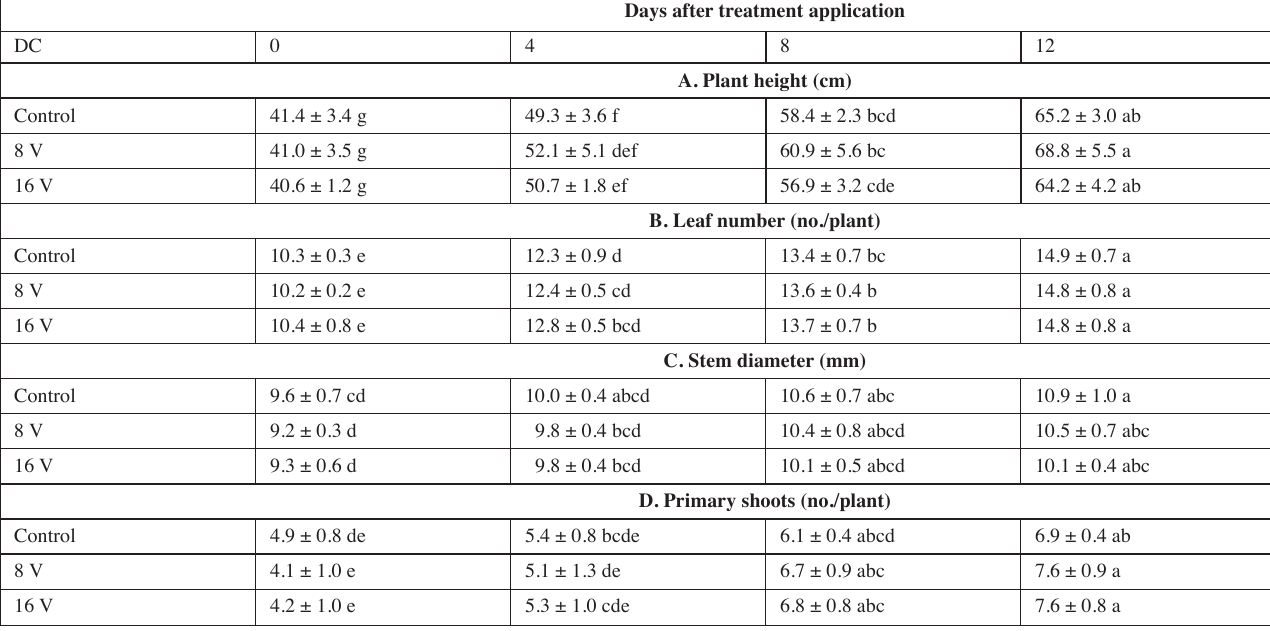
Tab. 1: Effect of different electrical voltages on growth parameters of African nightshade plants.